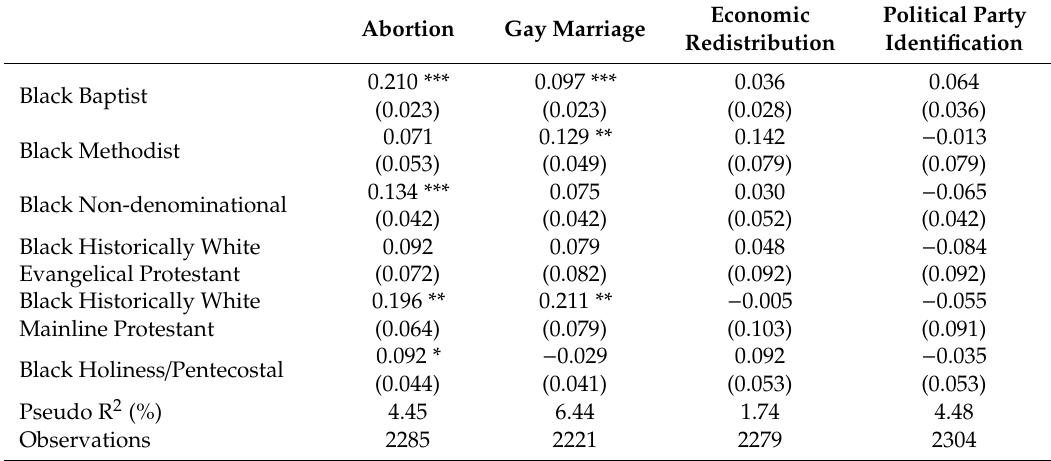
Table A4. E ff ects of education in logit models with the interaction of education and Black religious a ffi liation on political